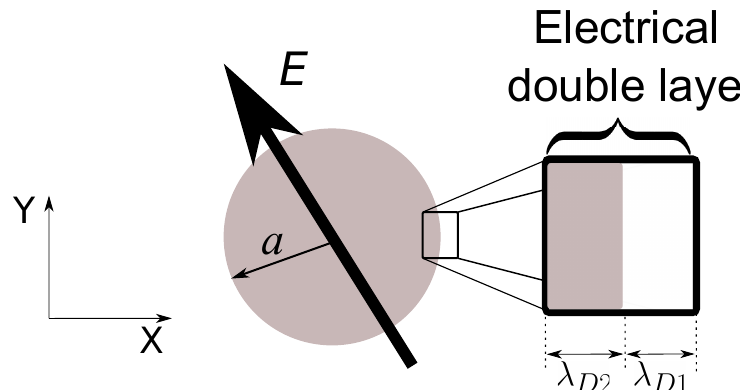
Figure 1. Semiconducting sphere of radius a subjected to an AC electric field. Electrical charges are induced at the particle-electrolyte interface giving rise to an electrical double layer